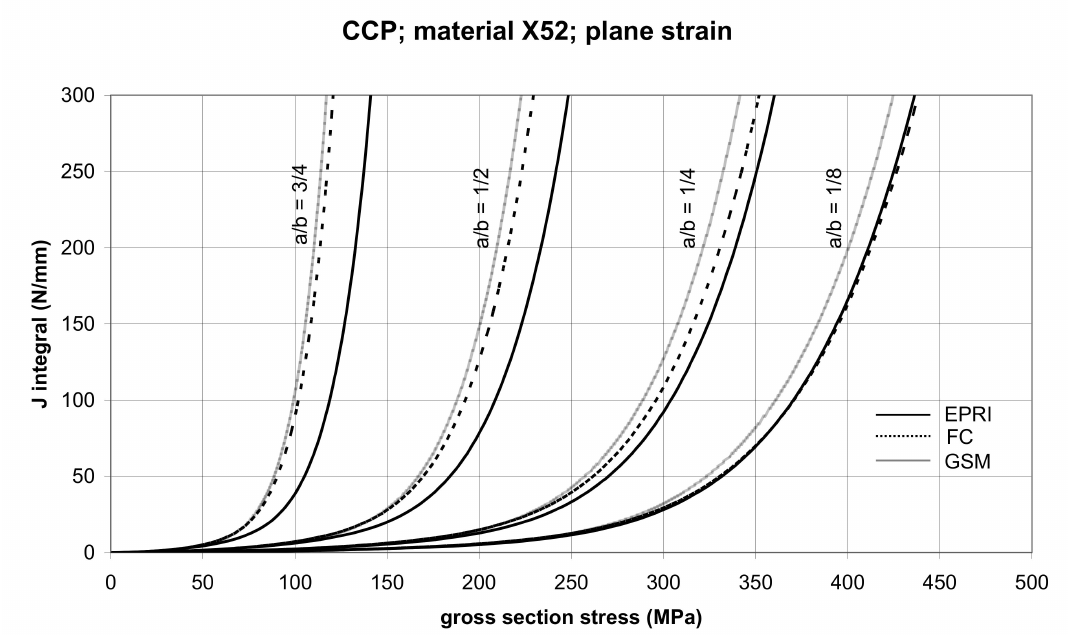
Figure 7. Comparison of J integral for CCP X52 steel specimens in the plane strain condition as determined by the EPRI, GSM, and FC